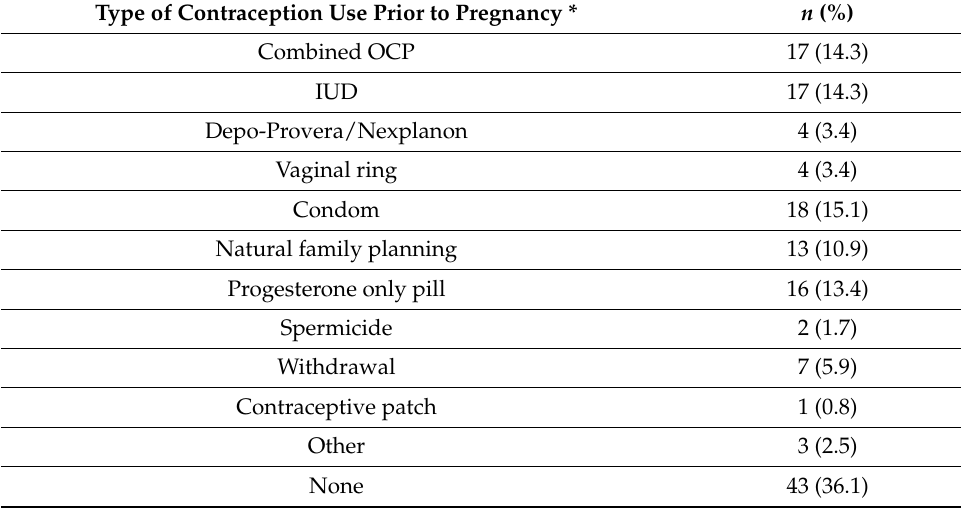
Table 2. Self-reported birth control use prior to index